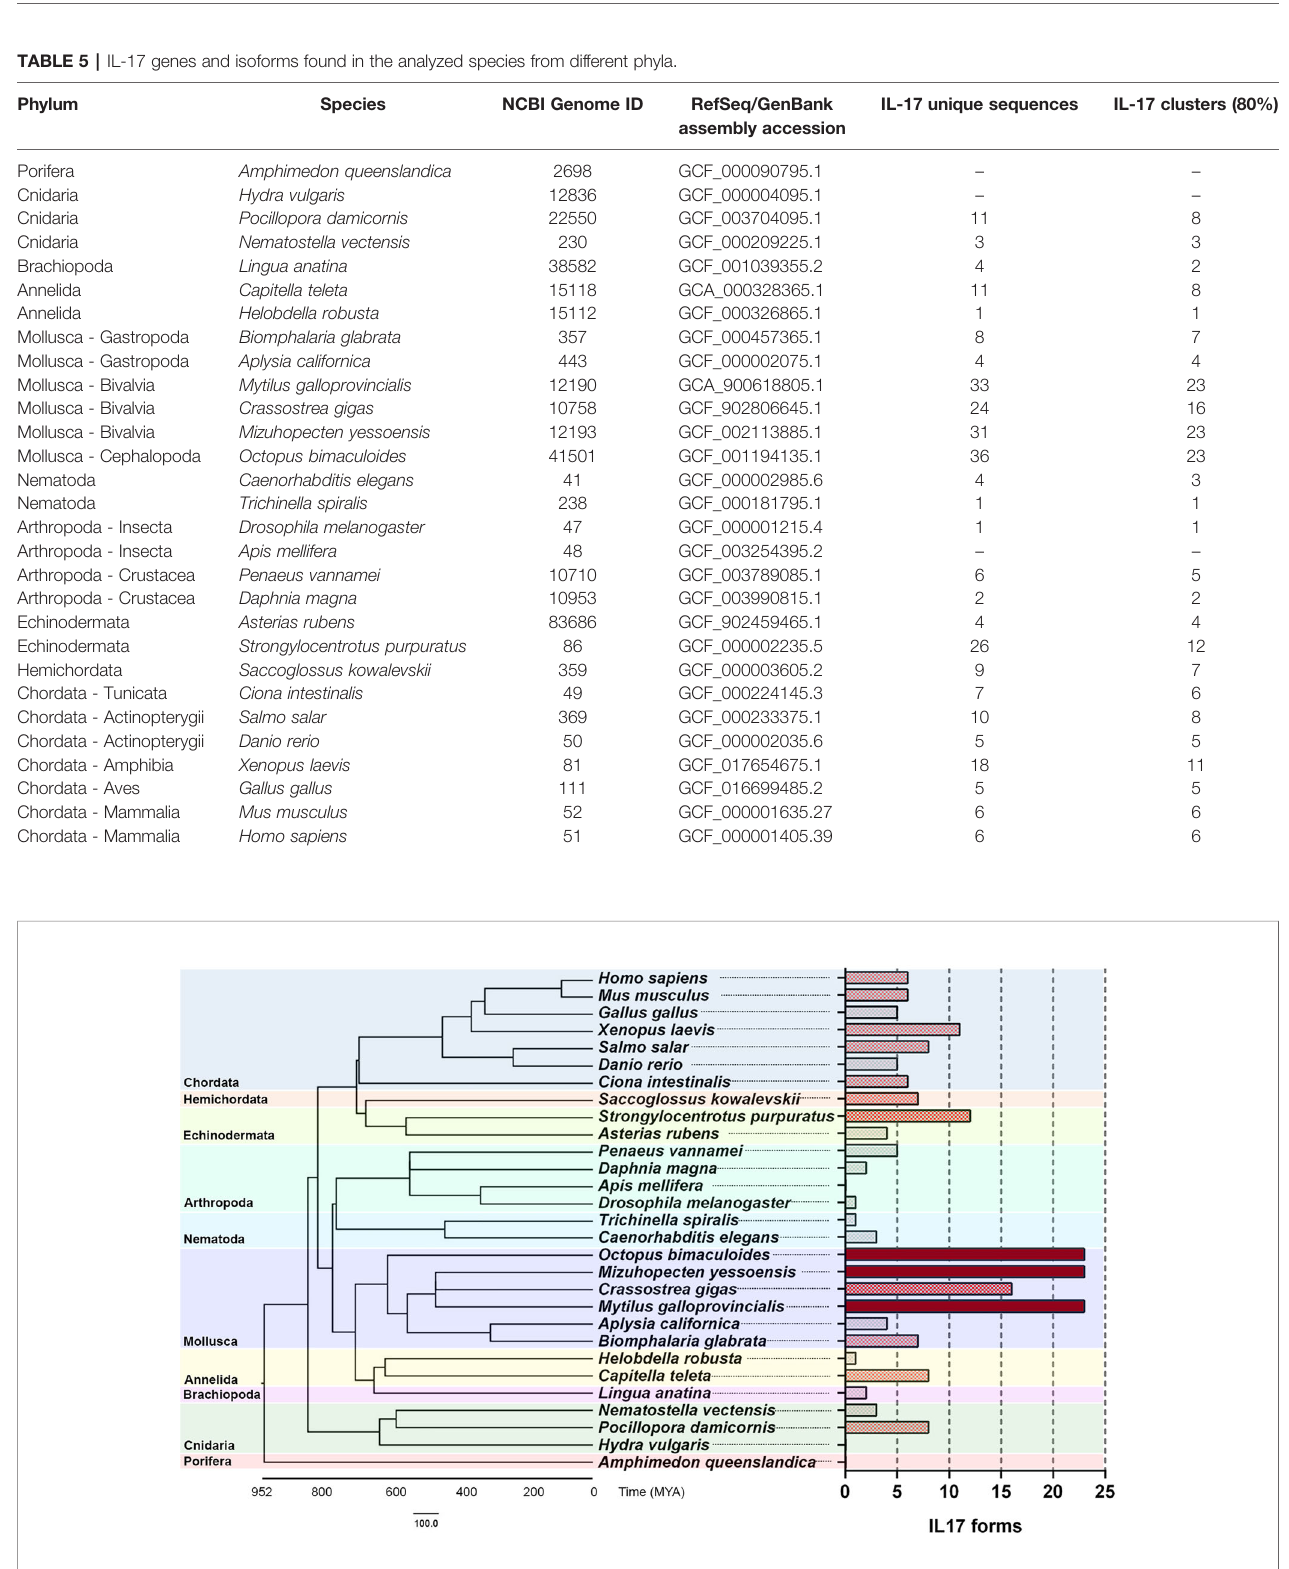
FIGURE 4 | Comparative genomics analysis of IL-17 gene families throughout evolution. IL-17 repertoires were analyzed in several species from different phyla and clustered with an 80% homology criterion. The evolutionary cladogram is presented, along with the extension of the IL-17 family from each